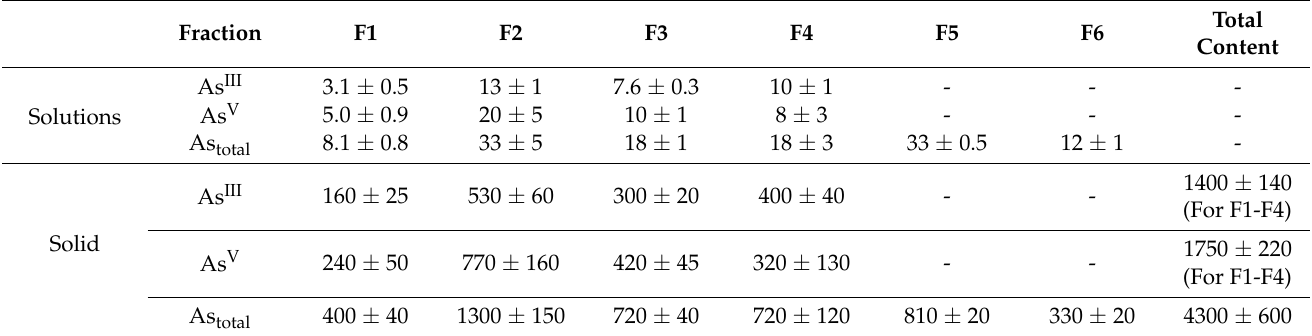
Table 4. Arsenic content in solutions (mg/L) and solid tailings (mg/kg).